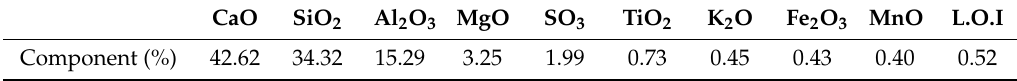
Table 2. Chemical components of Jumunjin sand.